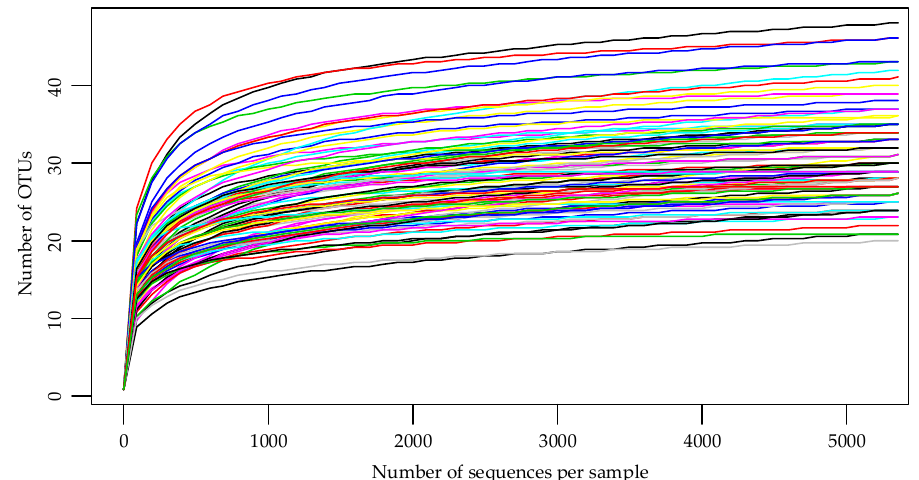
Figure 2. Rarefaction curves showing the amplicon sequencing depths in all samples. The number of observed operational taxonomic units (OTUs) was compared across samples when samples were rarefied at 5362